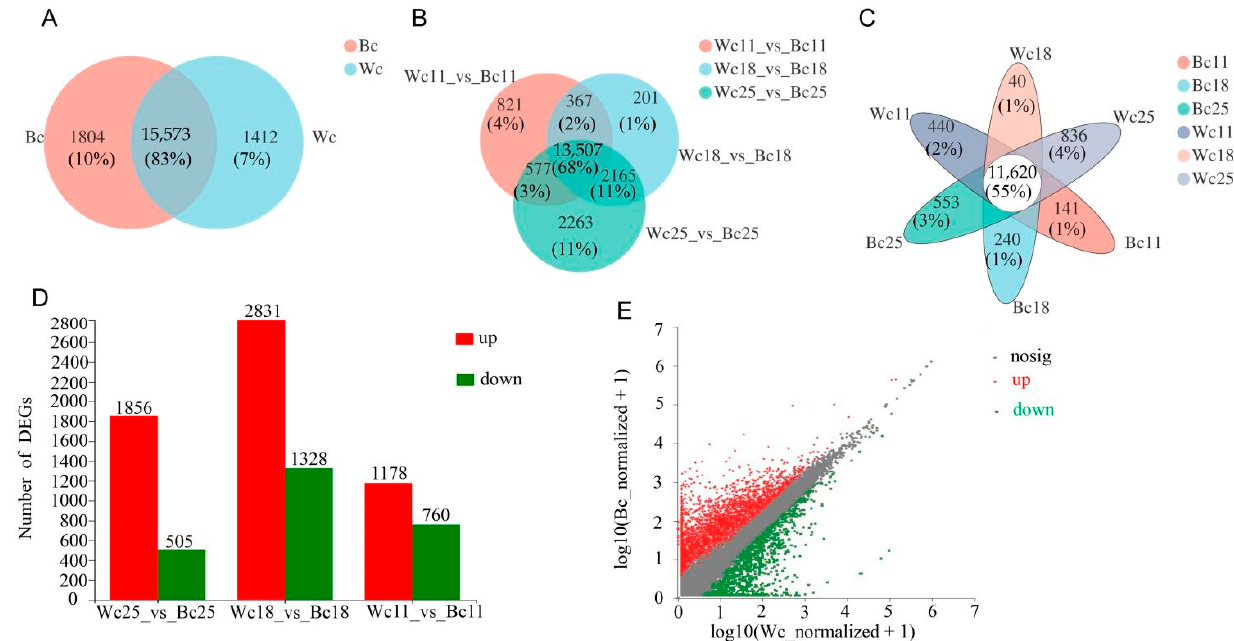
Figure 5. Comparison of transcript and gene abundance in black and white caryopsis. ( A ) Venn diagram of commonly expressed and unique genes in black and white rice caryopsis. ( B ) Venn diagram of the differentially expressed genes (DEGs) in the black and white caryopsis at different developmental stages. ( C ) Venn diagram of commonly expressed and uniquely expressed genes in a different sample at different stages. ( D ) The number of DEGs between black and white caryopsis at 25 DAF, 18 DAF, and 11 DAF. The red bars denote the upregulated genes and the green indicate the downregulated genes. ( E ) Scatter diagram with the abscissa and ordinate, respectively, represents the expression levels of genes in white and black caryopsis where the value of the abscissa and the ordinate were logarithmicized and each point represents a specific gene. Red dots show significantly upregulated, green dots represent genes that were significantly downregulated, and gray dots non-significantly different genes. The closer the point is to 0, the lower the expression level; the greater the deviation from the diagonal line, the greater the difference in expression of a gene between the two samples.